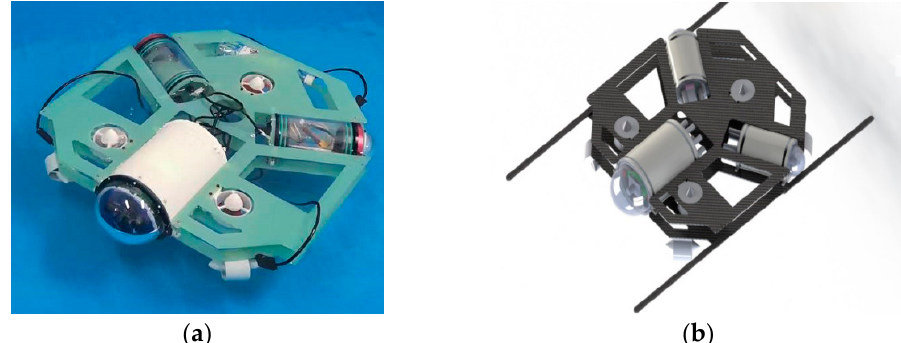
Figure 14. ( a ) The UUV used in the underwater experiment. ( b ) 3D model of UUV.